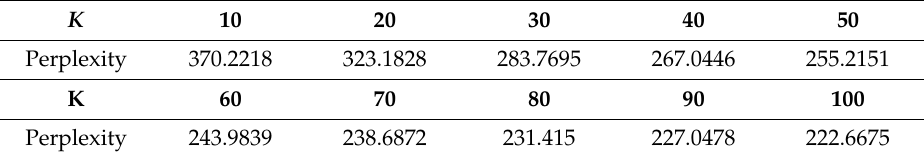
Table 1. Land cover classification model accuracy. Land cover classification models with different number of topics K contain different perplexities. Perplexity with higher value leads to with higher